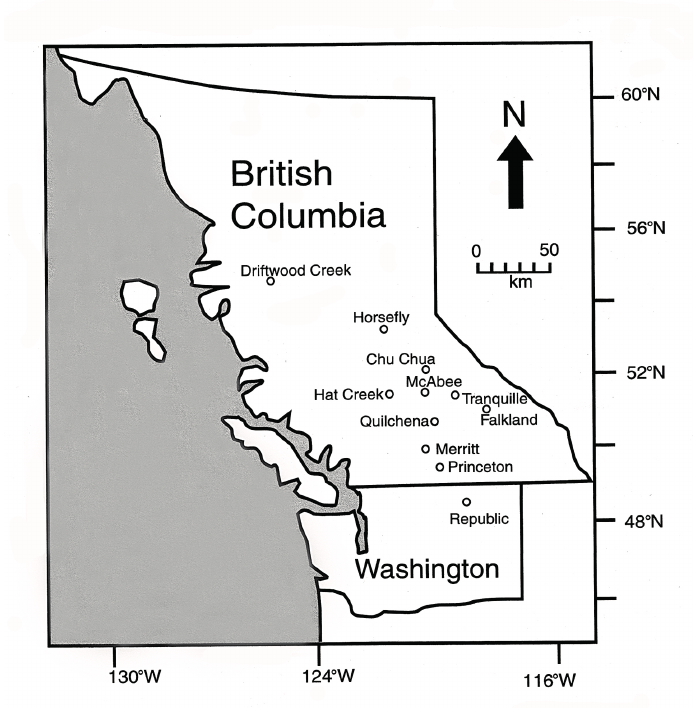
Figure 1. Eocene lacustrine deposits in British Columbia and Washington.